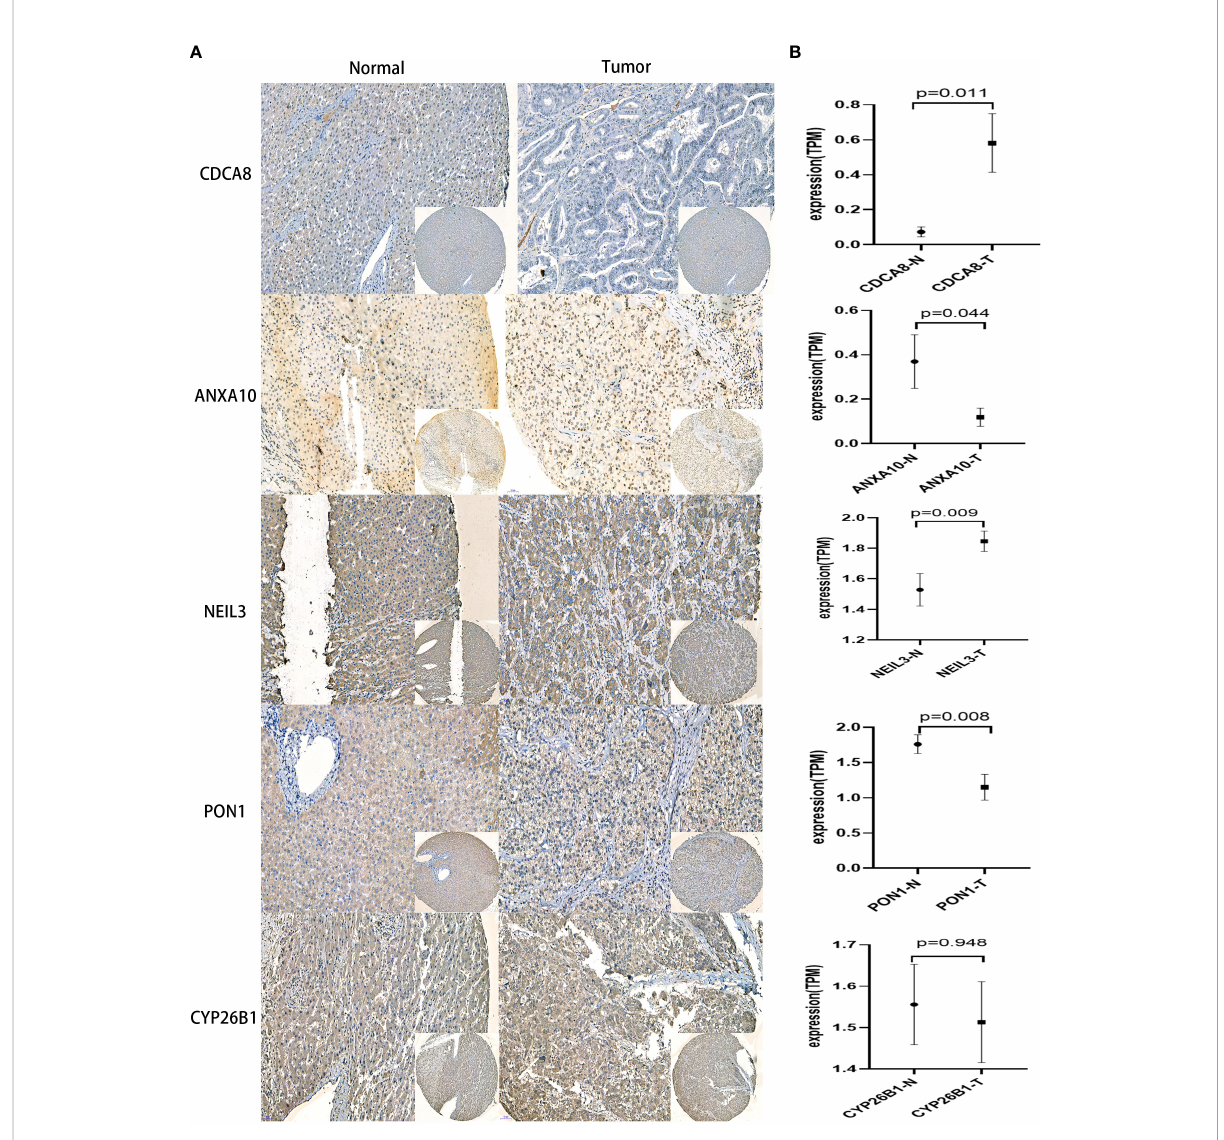
FIGURE 9 IHC analysis in the First Af fi liated Hospital of Wenzhou University cohort. (A) Representative IHC staining of CRsscore-related genes in HCC and normal tissues. (B) Comparison of the relative expression of CRsscore-related genes between HCC and normal tissues. *p<0.05,**p<0.01,